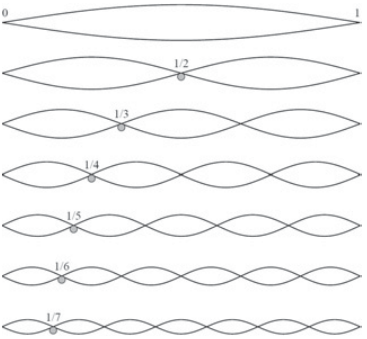
Figure 5. Harmonics of a string, based on sine and cosine functions